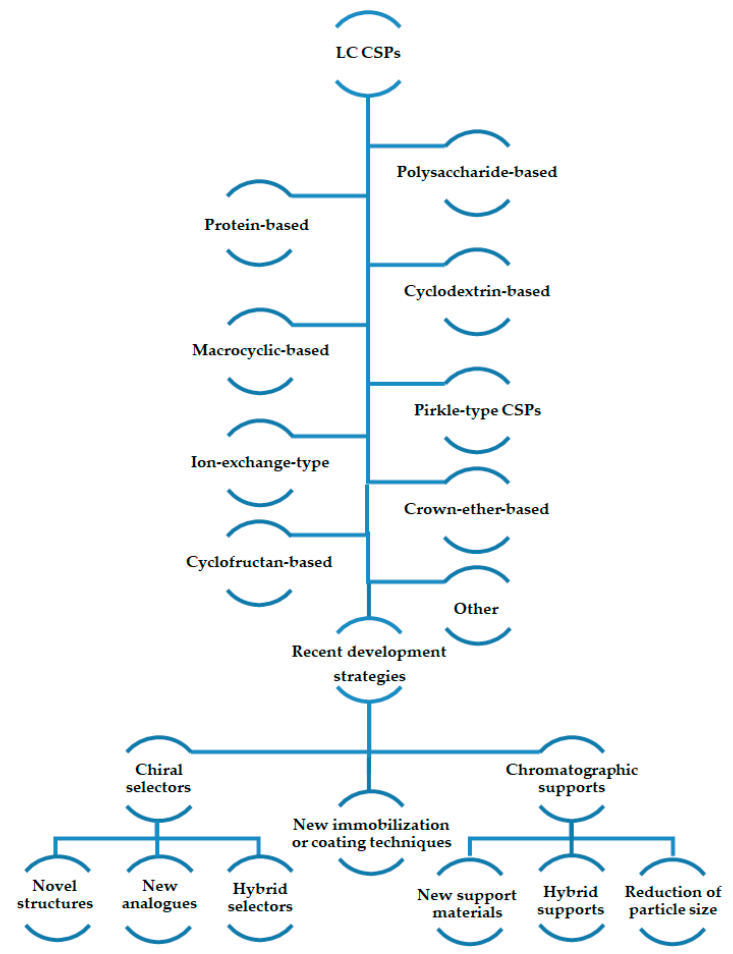
Figure 1. Summary of recent strategies for development of new chiral stationary phases (CSPs) for liquid chromatography (LC).